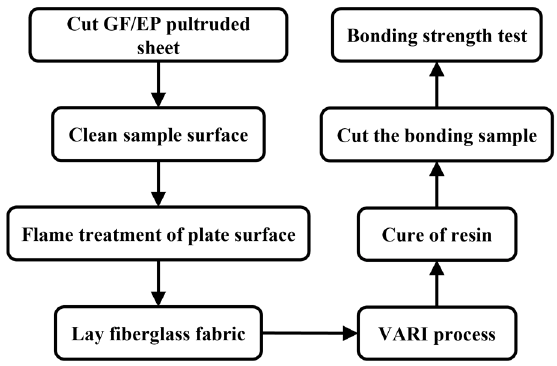
Figure 2. Schematic figure for the sample manufacturing.